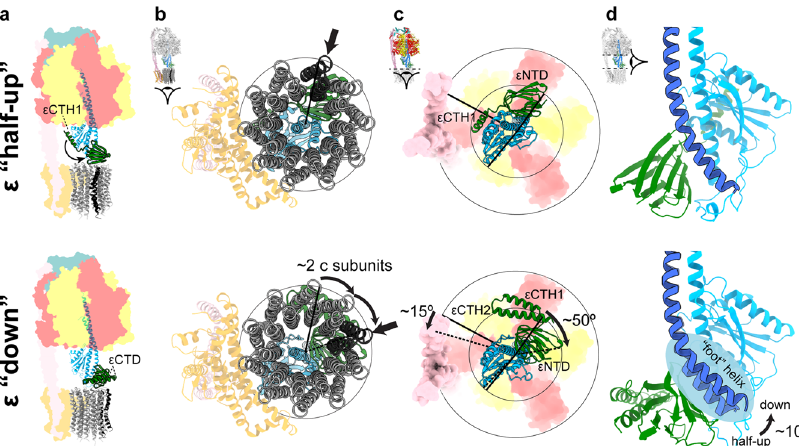
Fig. 4 Structural rearrangements of E. coli F 1 F o ATP synthase between the half-up and down conformations. Comparison of State 2 ε CTD half-up conformation (top panels) with State 2 ε CTD down conformation (bottom panels). a Overall view describing the ε CTD (green) transition and rotation of the c-ring (gray with one c subunit colored black). b When superposed on subunit a (orange), the c-ring rotates two c subunits in the F o motor (one c subunit colored black with black arrow — relative rotation of c subunits identi fi ed using the interaction between ε NTD and c subunit; Supplementary Fig. 6). c When superposed on the β barrel crown of the α and β subunits, the ε NTD rotates ~50° about the γ subunit and the peripheral stalk fl exes ~15°. d When superposed on N-terminus of subunit γ , the foot helix (residues γ 39-57) bends and twists to accommodate the movement of the ε NTD.